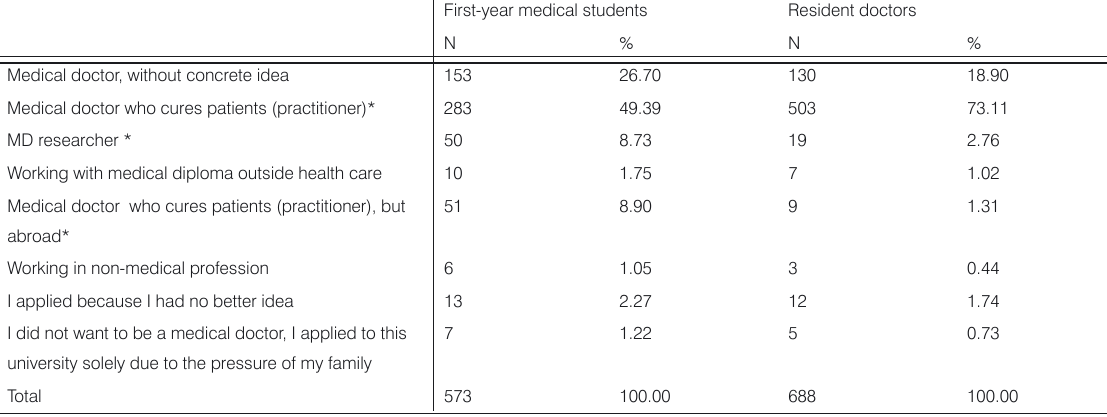
* significant difference according to the two sample t-test. p <